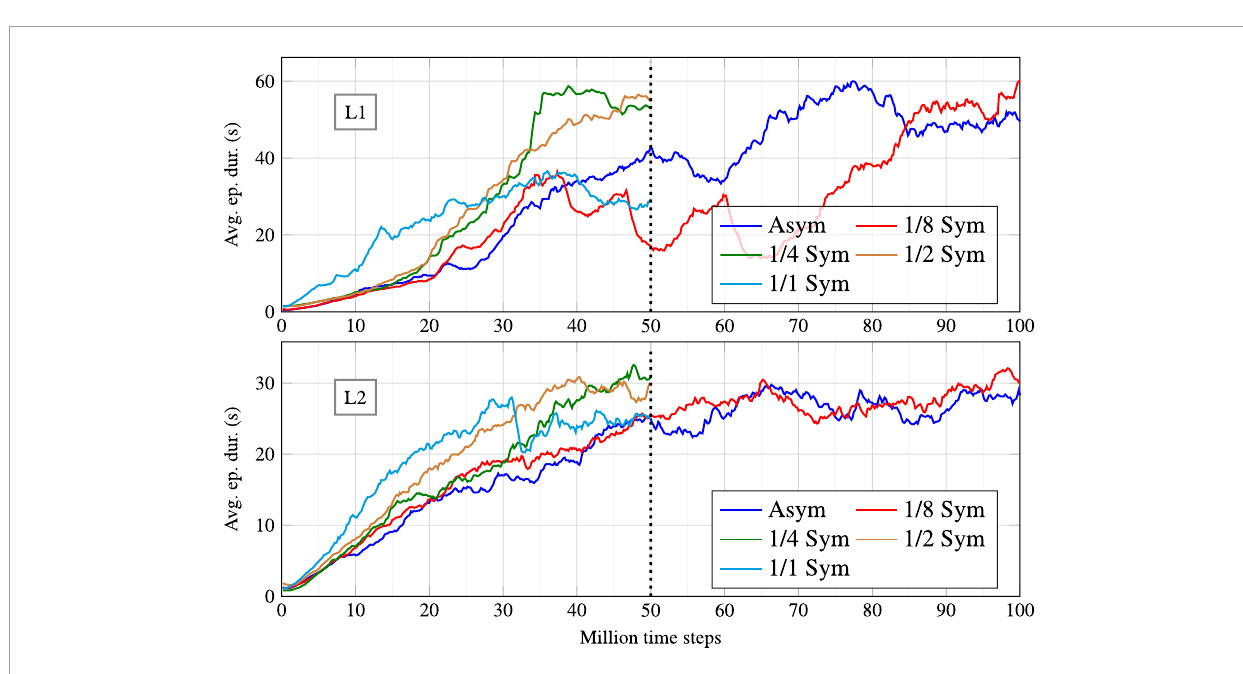
FIGURE 5 Learning curves for the policies trained in scenario L1 (top) and L2 (bottom), under different symmetry configurations.